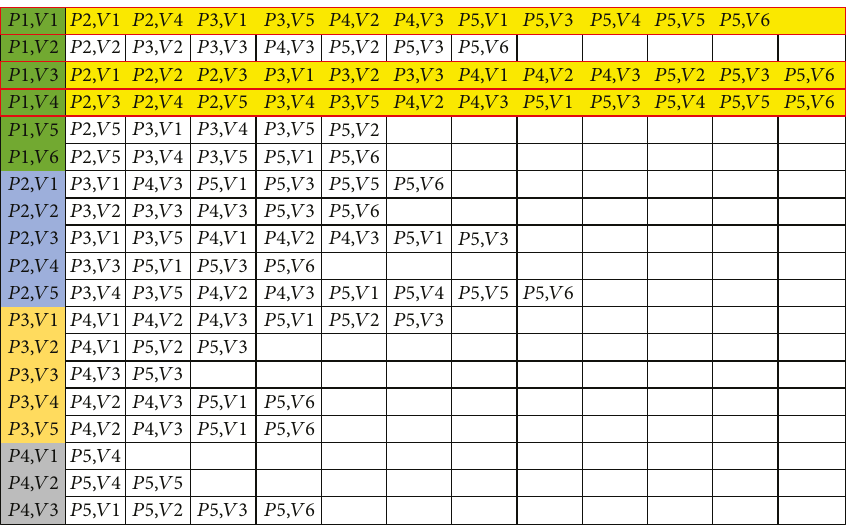
Figure 4: Results of cross-consistency assessment, highlighting the parameter values that generate optimal pairwise